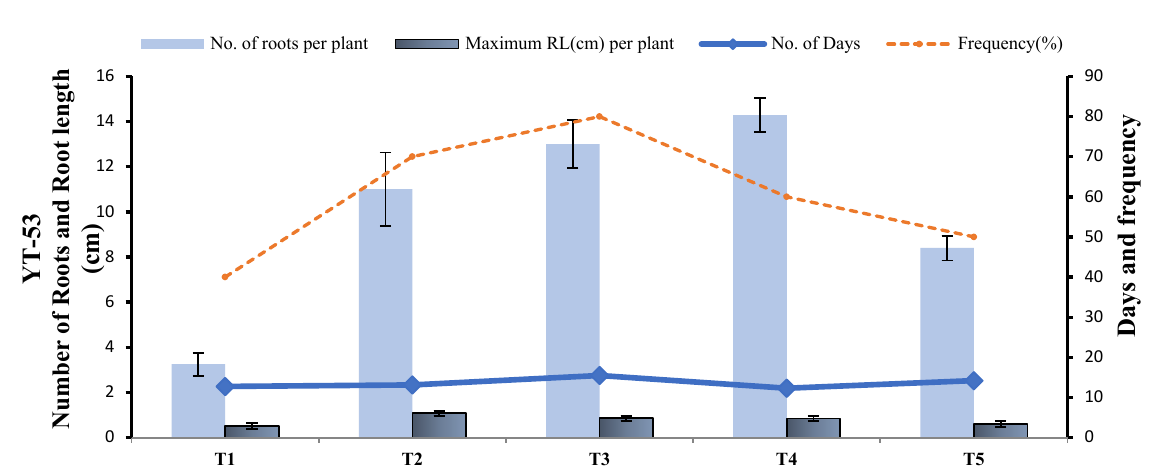
Figure 13. Effect of five treatments on root induction in terms of root length (cm), number of roots, rooting frequency and number of days in YT-53.